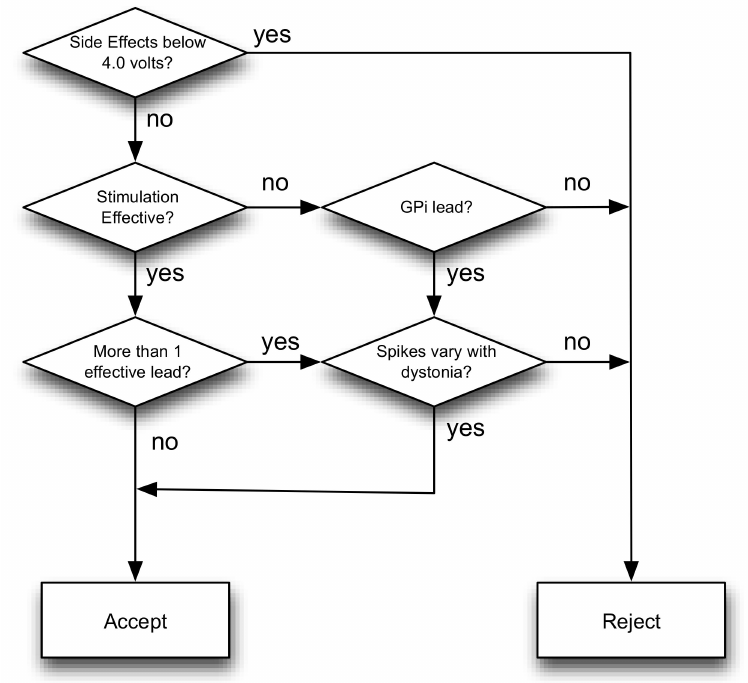
Figure 3. Simplified flowchart of decision-making process based on NMU data. When more than 1 lead is effective during stimulation, we select the lead for which the single-cell spikes correlate most closely with dystonic muscle